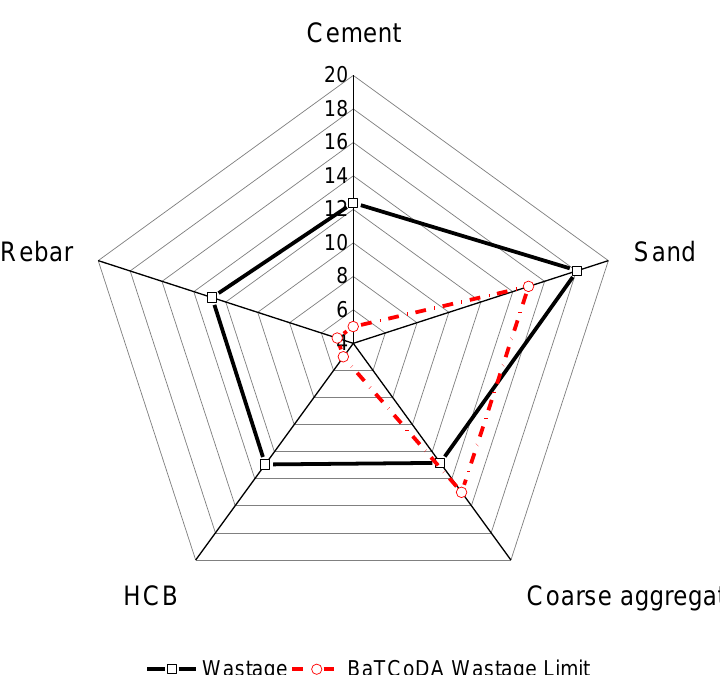
Figure 2. The percentile portions of waste of the five materials along with waste limits set by the national BaTCoDA standard [34].